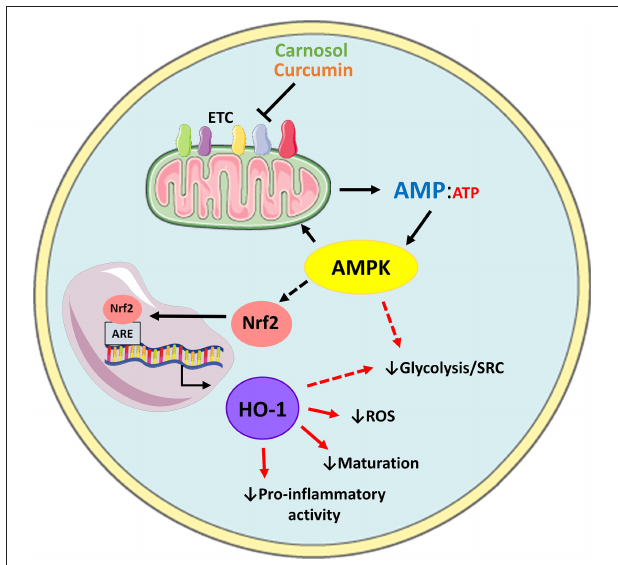
FIGURE 6 | Proposed model of AMPK-dependent modulation of human DC metabolism and immune function by carnosol and curcumin. Carnosol and curcumin are polyphenols which have been shown to inhibit components of the ETC, resulting in reduced ATP production and elevated AMP levels. AMP activates AMPK, which results in downstream activation of Nrf2. Nrf2 translocates to the nucleus and induces transcription of HO-1. HO-1 and its products can then act as antioxidants to neutralize ROS produced by mitochondrial metabolism, and downregulate DC maturation and pro-inflammatory functions. Additionally, AMPK or HO-1 may mediate the reduced rate of glycolysis and SRC observed in carnosol- and curcumin-treated DC (red dashed